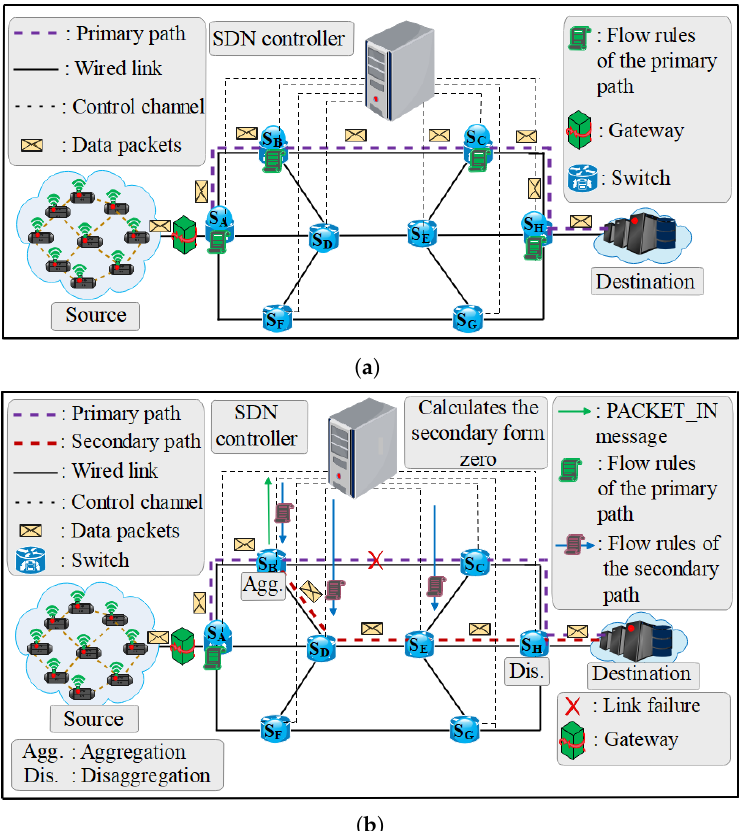
Figure 3. Example of Local Fast Reroute (LFR) application for the SDN platform ( a ) Before an intermediate link S B → S C failure. ( b ) After an intermediate link S B → S C